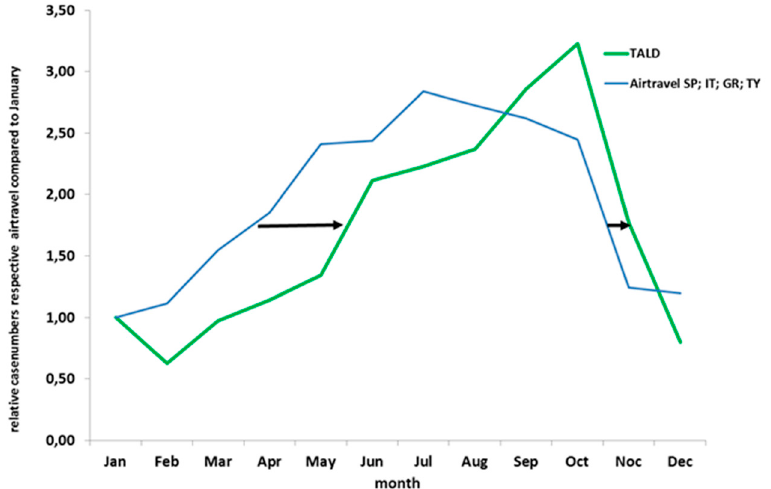
Figure 5. German data (pooled data 2011–2015) travel-associated cases relative to January compared to number of air travel (flights from Germany to Spain (SP), Italy (IT), Greece (GR) and Turkey (TY) in 2011–2015) by month.